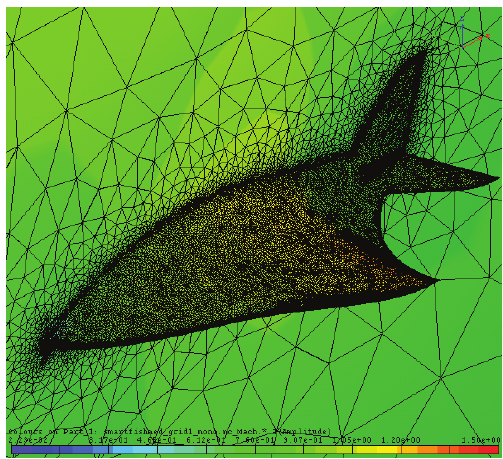
Figure 18: Adapted coarse grid with respect to the Mach di ff erence. 1 adaptation cycle with refinement and derefinement at the Mach number 0.9 and angle of attack 4 ◦ , 1795794 elements and 302 723 nodes.